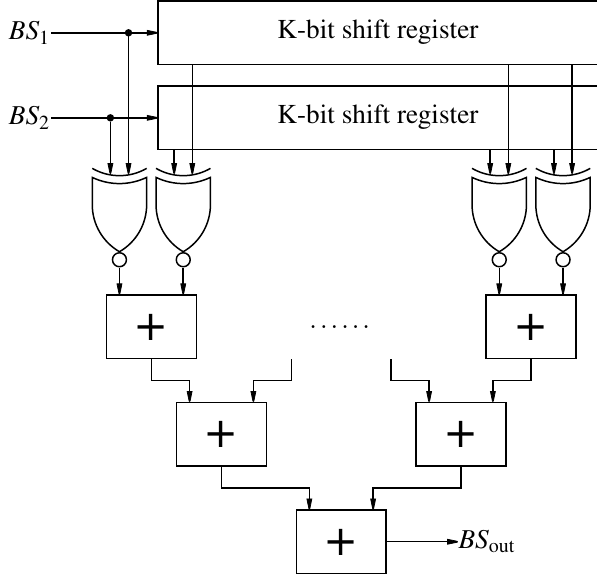
Figure 22. Modified multiplication of two bit-streams based on Delta Adder.